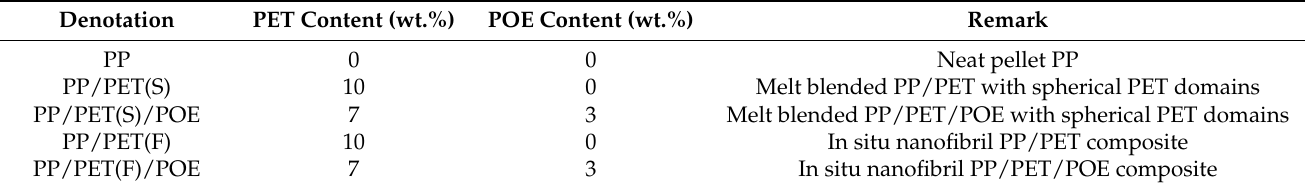
Figure 1. Schematic fabricating of INF composites and foams. Table 1. Formulations of Neat PP and PP based